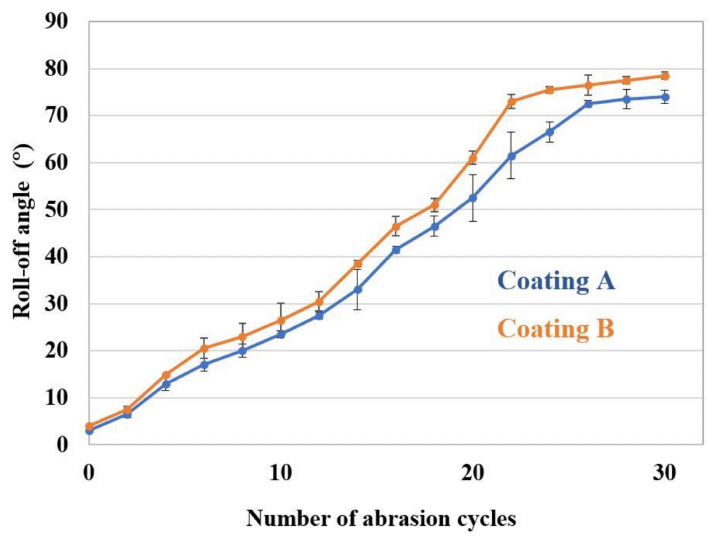
Figure 11. Roll-off angles after the Taber abrasion test against 29.9 kPa normal load.